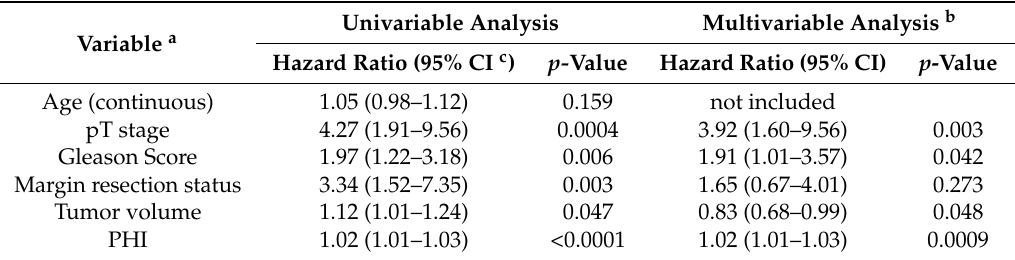
Table 6. Cox proportional hazard regression analyses of tumor volume and PHI in relation to conventional clinicopathological variables for predicting biochemical recurrence after radical